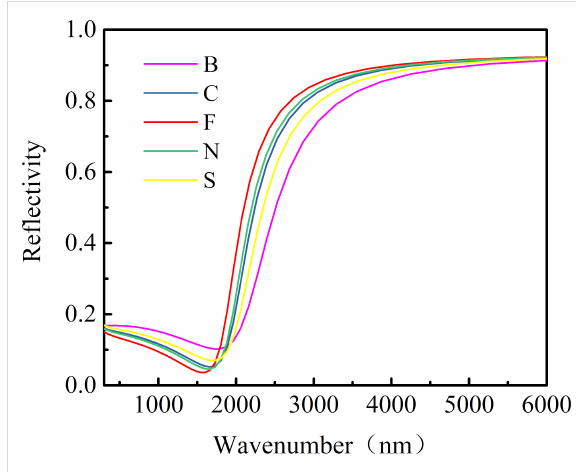
Figure 4: The reflection spectrum of SnO 2 of O atom replaced by non- metal